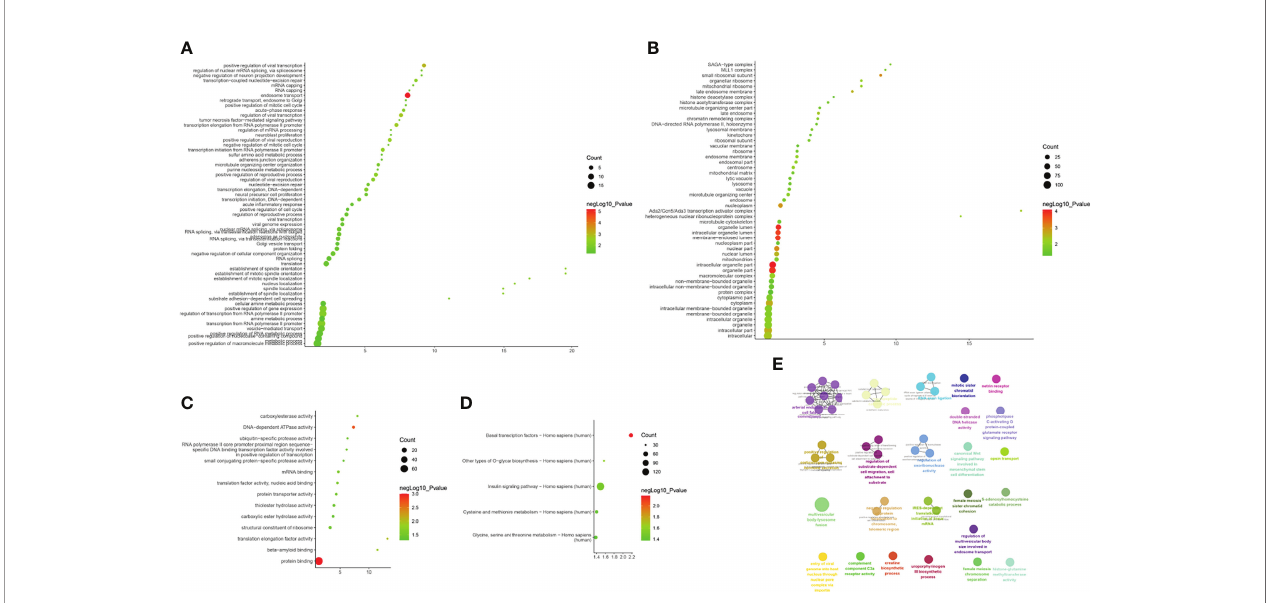
FIGURE 8 | Enrichment Analysis of down-regulated mRNAs [ (A) biological processes; (B) cell components; (C) molecular functions; X-axis stands for fold enrichment. (D) Signaling pathway; X-axis stands for enrichment score. (E) Enrichment results].